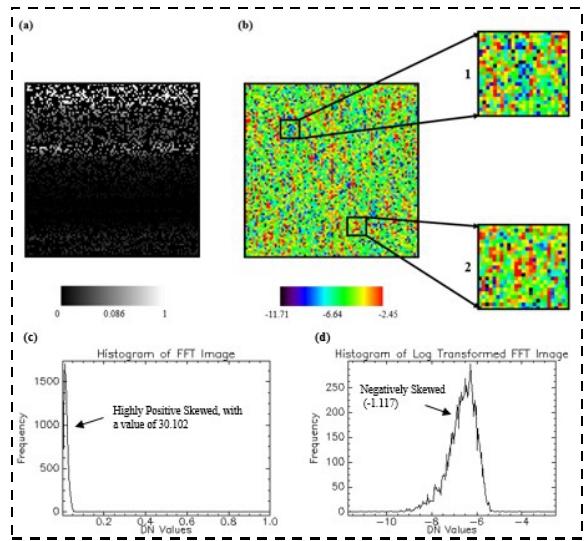
Figure 7. (a) Original simulated spatial domain 3 He retained image, (b) Log transformed FFT image, (c) Histogram of FFT image before power transformation, and (d) Histogram of LPT- FFT image, with modal abundance and variance of -6.25 and 0.44 respectively.